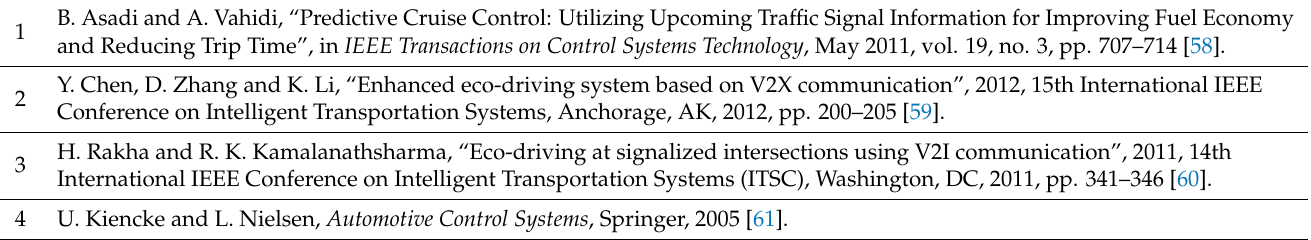
Table 2. Most influential documents chosen among the 67 influential references by manually excluding impertinent